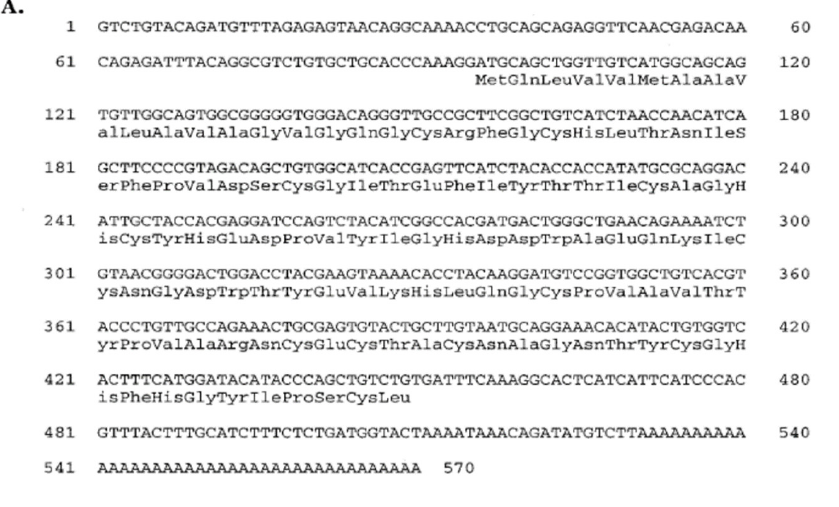
Figure 15. Nucleotide sequences of blue gourami FSH- β ( A ) and LH- β ( B ). The amino acid sequence. of each hormone appears in three-letter code. The GenBank accession numbers of these sequences are AF157630 and AF157631, respectively [34]. Comparison of FSH- β and LH- β are shown in Figure 16. The blue gourami FSH- β was most similar to its striped bass counterpart, with the two polypeptides sharing 73% of their residues. The lowest similarity was found between blue gourami and of goldfish FSH- β , with only 44% similarity (Figure 17A) [34]. A dendrogram, graphically representing these polypeptide comparisons, showed highest similarity between blue gourami and striped bass FSH- β , with 84% identical residues (Figure 17A). For LH- β , the lowest similarity was found with the Coregonus migratorius , a whitefish of the Fam- ily Salmonidae. (only 65% identical residues). The dendrogram showing the relation- ships between the LH- β polypeptides is presented in Figure 17B [34]. Figure 16. A comparison of the amino acid sequences of FSH- β (gth1) and LH- β (gth2). Identi- cal amino acids are. boxed in black; residues with similar physicochemical properties are boxed in gray [34].